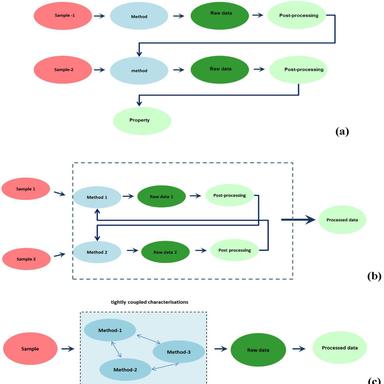
Visual representation of (a) sequence of multiple-samples/actions and multiple data processing steps, and (b) iterative workflow and (c) an example of coupled characterizations.